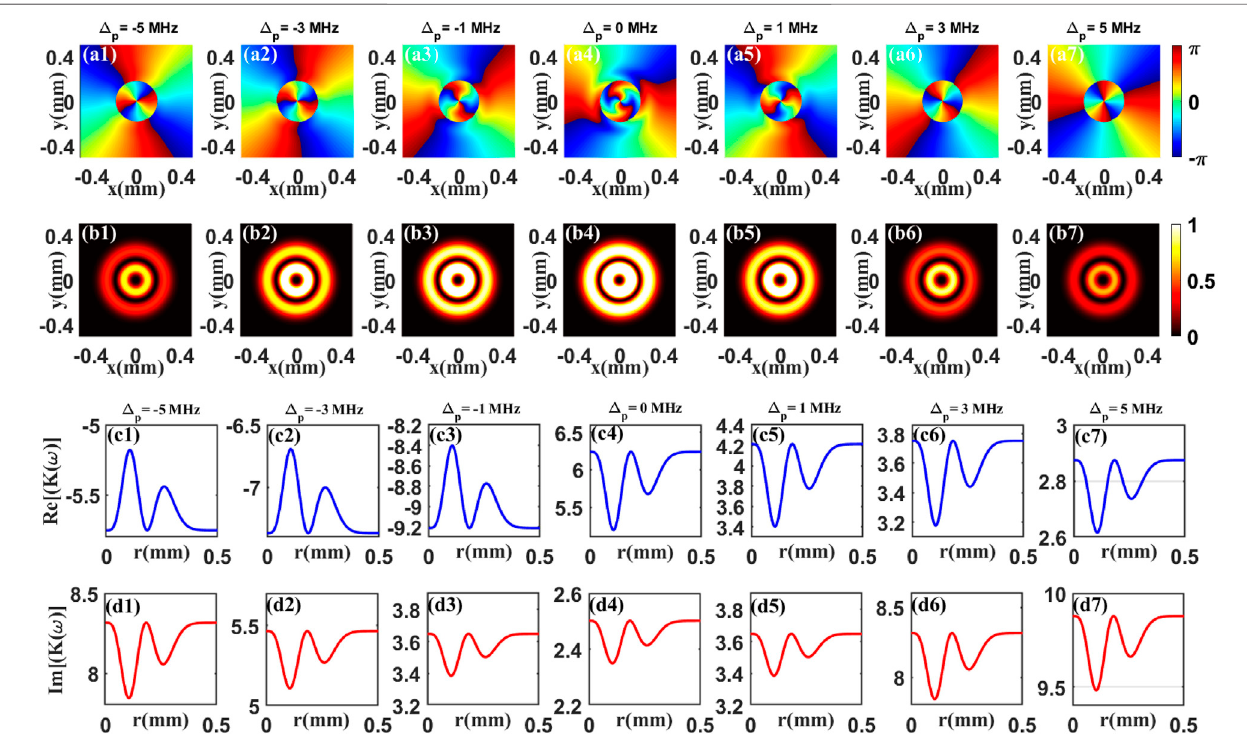
FIGURE 2 | Phase (A1 – A7) and normalized intensity (B1 – B7) patterns of the FWM fi eld for different probe detuning Δ p . The real (C1 – C7) and imaginary (D1 – D7) partsofdispersionrelation K ( ω )versusradius r fordifferentprobedetuning Δ p .Theotherparametersare ω 0 =0.18mm, R p =3 ω 0 , ω =3MHz, z =15mm, p =1, l =2, γ 1